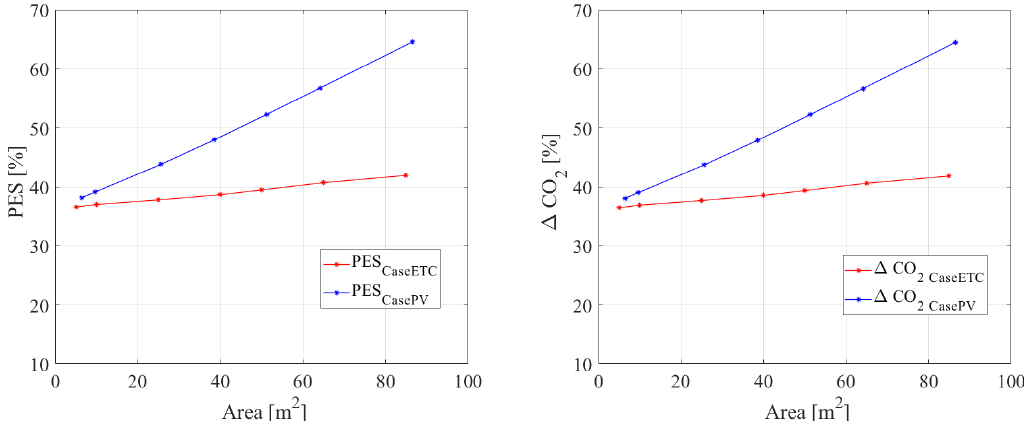
Figure 13. Parametric analysis: PES ( left ) and avoided equivalent CO 2 emissions ( right ).